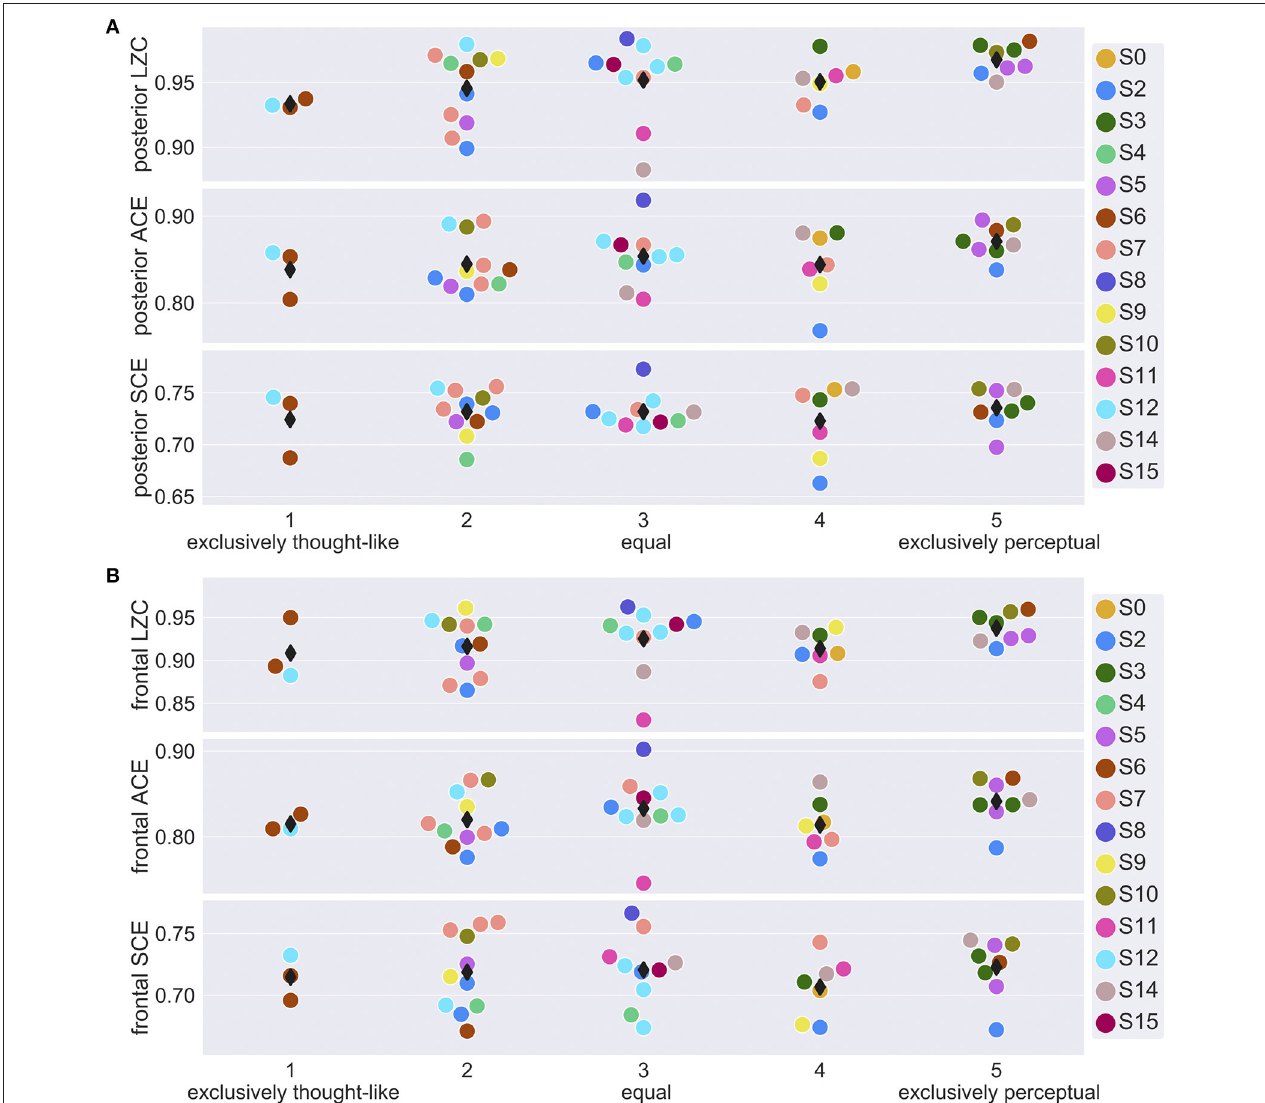
FIGURE 3 | EEG signal diversity vs. thought-perceptual ratings of dream experience. (A) Mean posterior (see Figure 1A ) signal diversity of the last 30s sleep epoch before NREM2 awakenings with recalled dream experience, vs. thought-perceptual ratings of dream contents (1 = exclusively thought-like, 5 = exclusively perceptual). Participant number (S0, …, S16) is indicated by marker fill color, and observations are displaced slightly along x-axis to avoid overlap. (B) Mean frontal (see Figure 1A ) signal diversity of the last 30s sleep epoch before NREM2 awakenings with recalled dream experience, vs. thought-perceptual ratings of dream